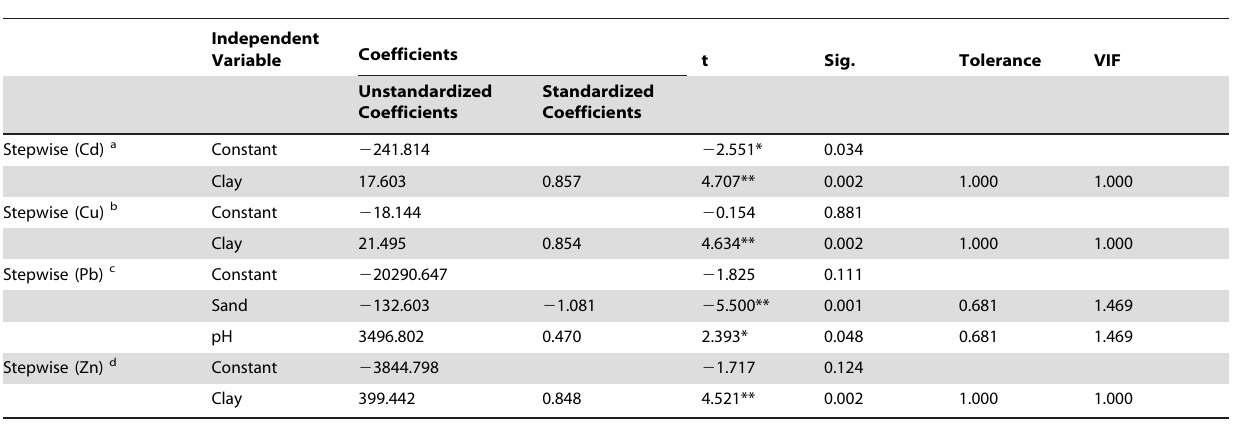
Table 8. The results of regression coefficients and collinearity diagnosis.